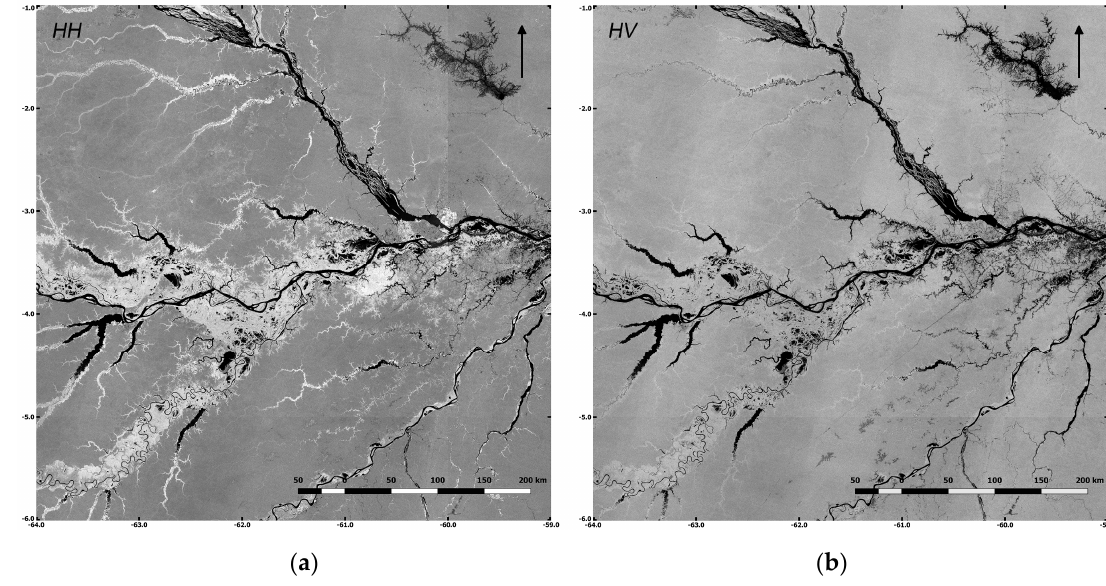
Figure 1. ALOS-2 PALSAR-2 ScanSAR 5° × 5° tile composite (PALSAR-2 cycle 27, July 2017) over the Central Amazon Basin. ( a ) HH-polarization. ( b ) HV-polarization (© JAXA).